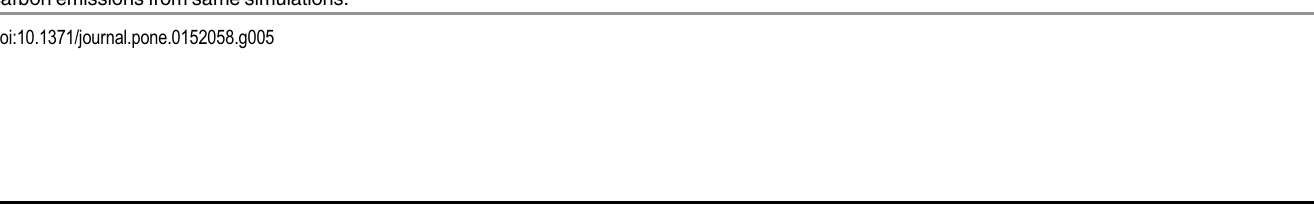
PLOS ONE | DOI:10.1371/journal.pone.0152058 March 24,